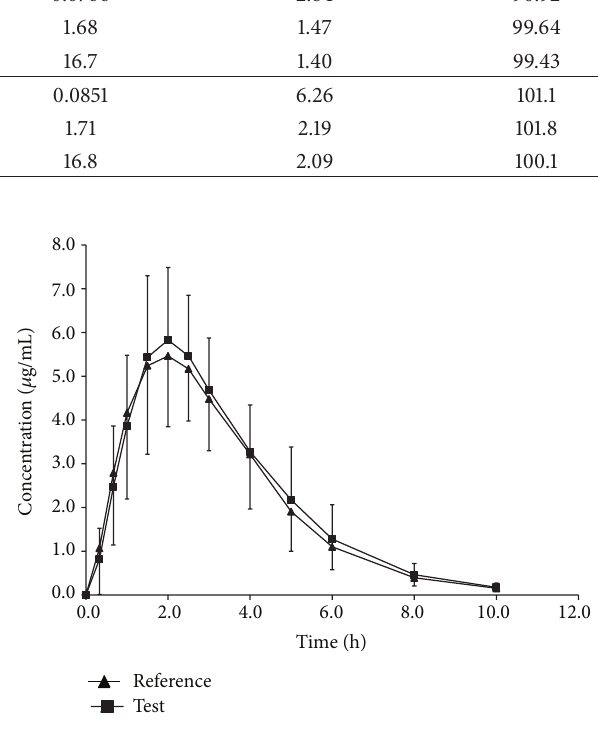
Figure 3: Mean plasma concentration-time profile of cefuroxime after oral administration of test and reference formulations to 22 healthy male